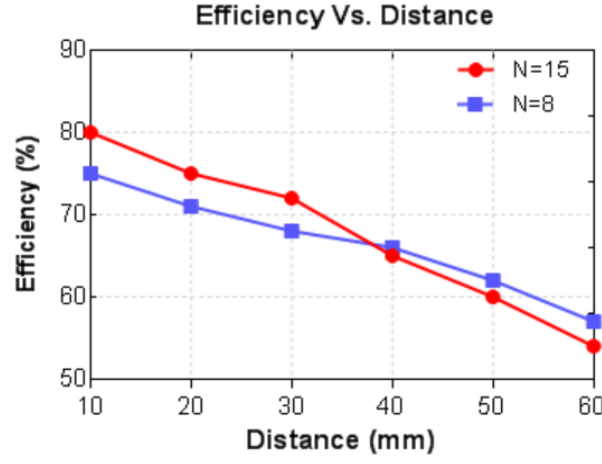
Figure 14. Effect of coil turns on efficiency. Table 5. Comparison between different coupling